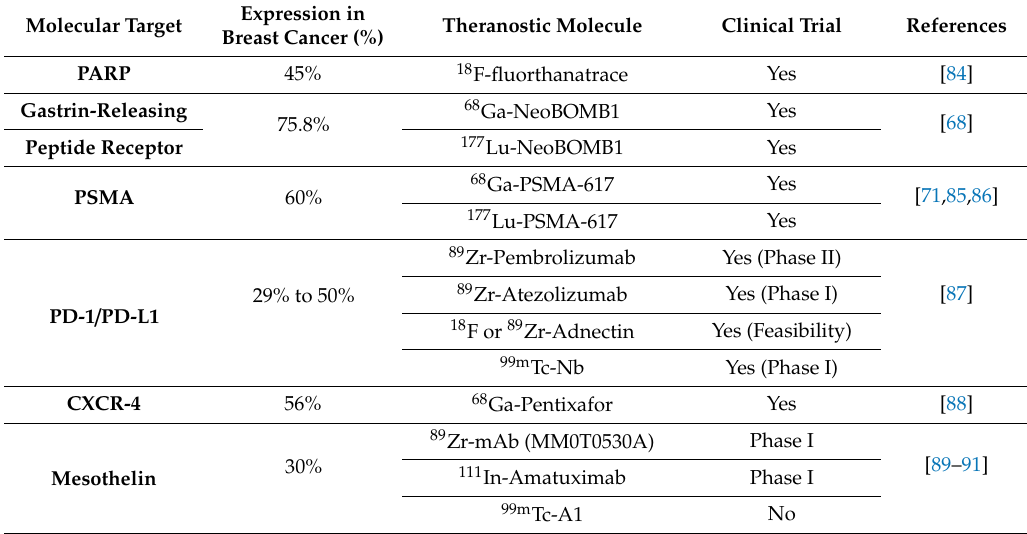
Table 1. Targets and radioligands for phenotypic imaging of metastatic breast